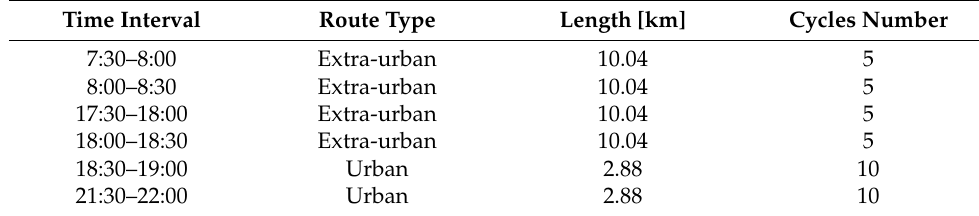
Table 5. Mobility pattern 3 definition.